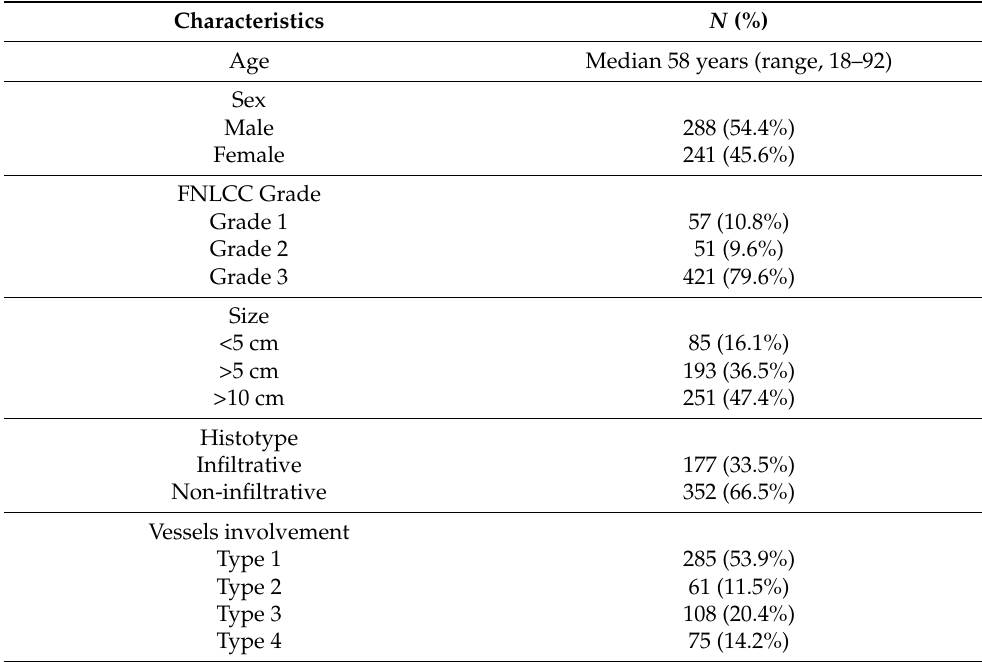
Table 1. Patients’